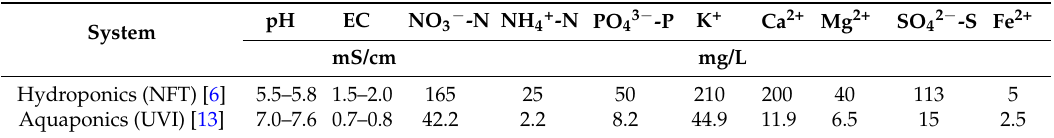
Table 1. Optimal nutrient solutions for lettuce growth using nutrient flow technique (NFT) and in the University of the Virgin Islands (UVI)